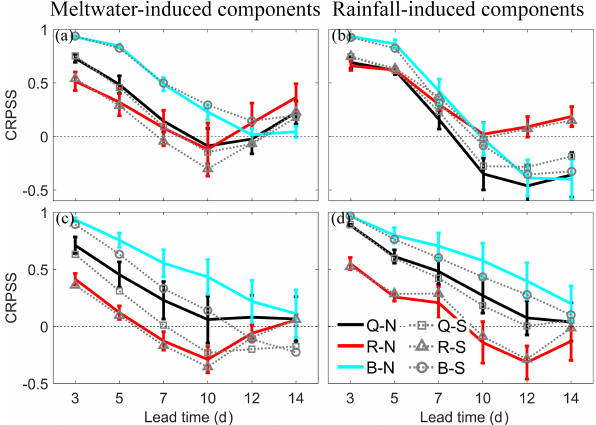
Figure 12. CRPSS of four different streamflow components against lead time at Nuxia. Meltwater-induced components for first floods (a) and maximum floods (c) and rainfall-induced components in first floods (b) and maximum floods (d) . The thick and solid lines are CRPSS by N simulations, with vertical bars showing 95% con- fidence intervals, and the dashed lines with different markers are CRPSS by S simulation. Black lines are snowmelt and rainfall com- ponents in total runoff ( Q ). Red lines are CRPSS for components in surface runoff ( R ), and blue lines are in base flow ( B